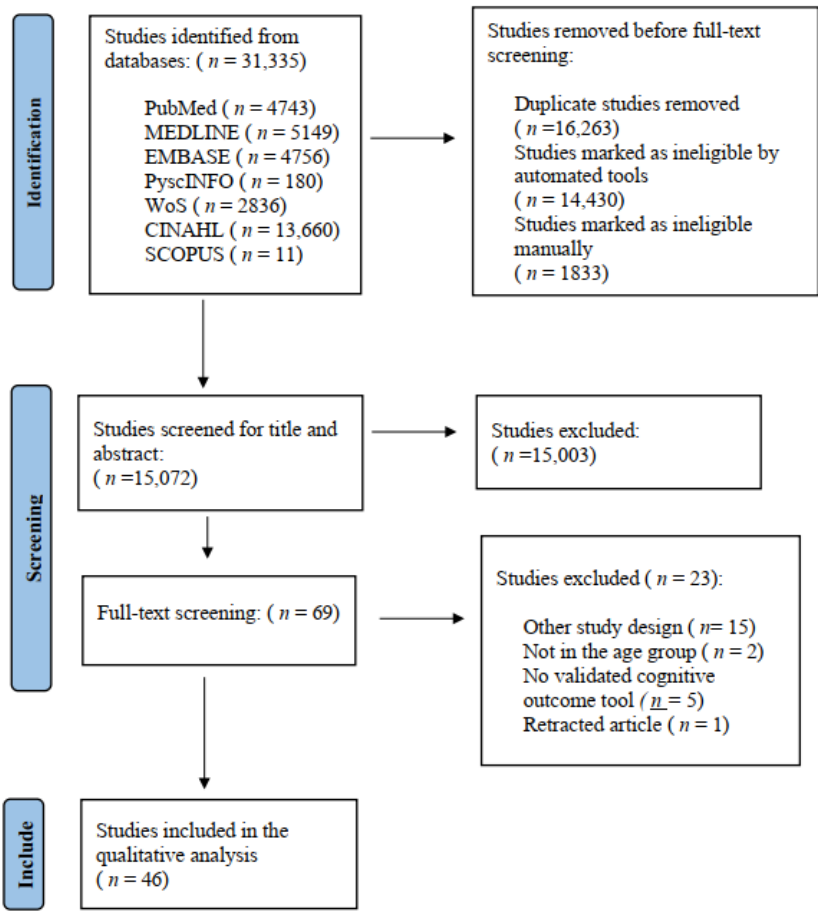
Figure 1. PRISMA flow diagram depicting the process of article screening. A summary of the extracted data, including information on author, year, country, study design, sample size, age, gender, level of fluoride exposure, and type of cognitive outcome measurement, is provided in Supplementary Table